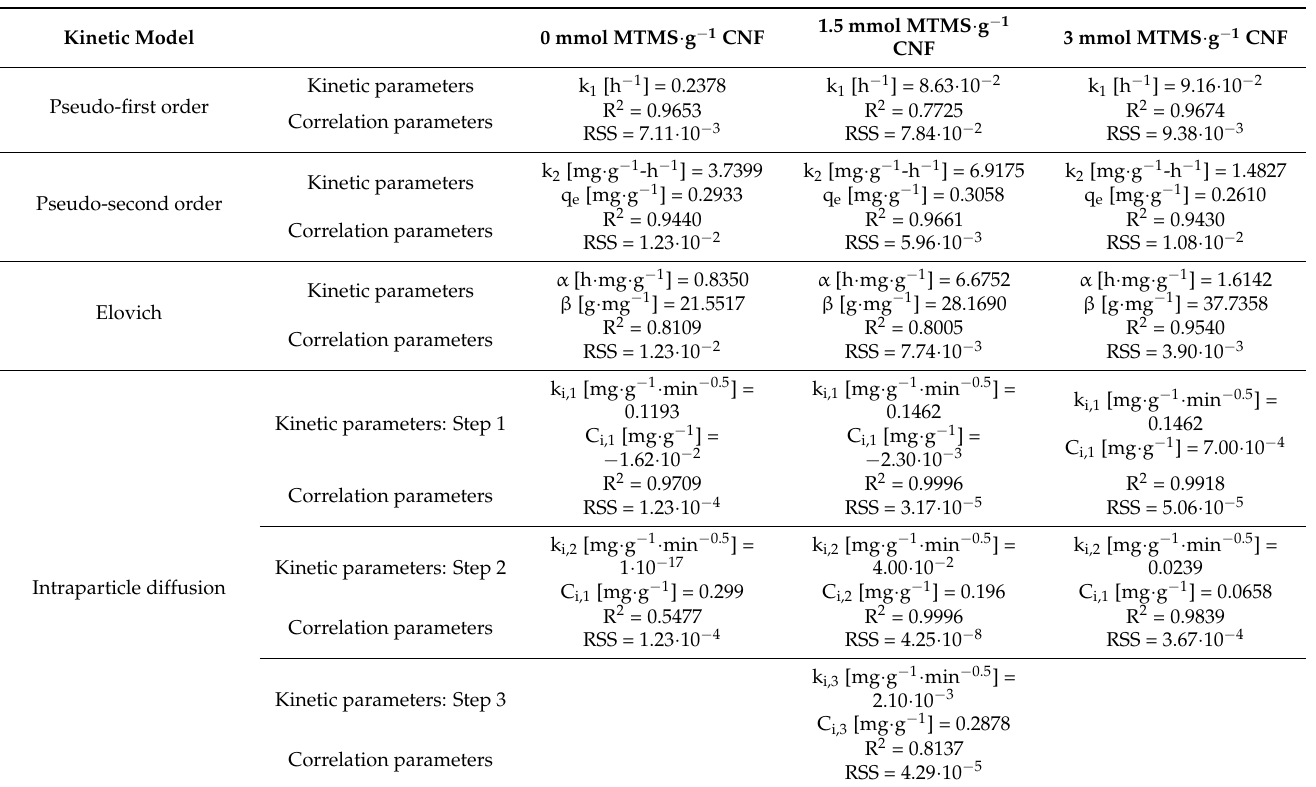
Table A1. The results of the kinetic equation adjustment to the adsorption experimental data of 0–3 mmol MTMS · g − 1